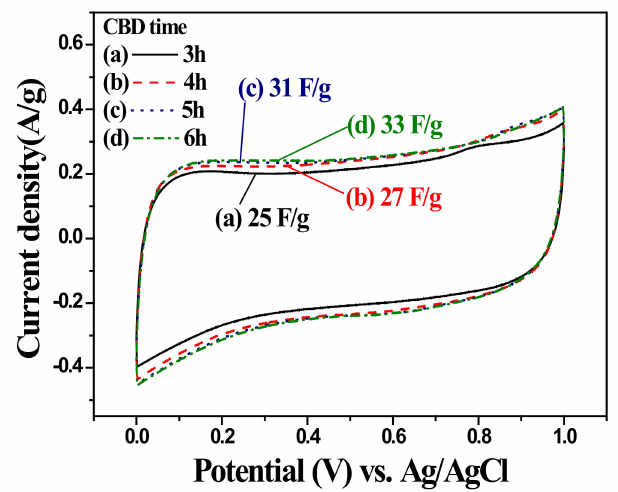
Figure 7. Cyclic voltammograms of ZnO nanorod measured from the 50th cycle in 1.0 M Na 2 SO 4 electrolyte at a scan rate of 25 mV / s as a function of CBD time. The ZnO nanorods were deposited under growth condition of pH = 6 by CBD at 70 ◦ C.